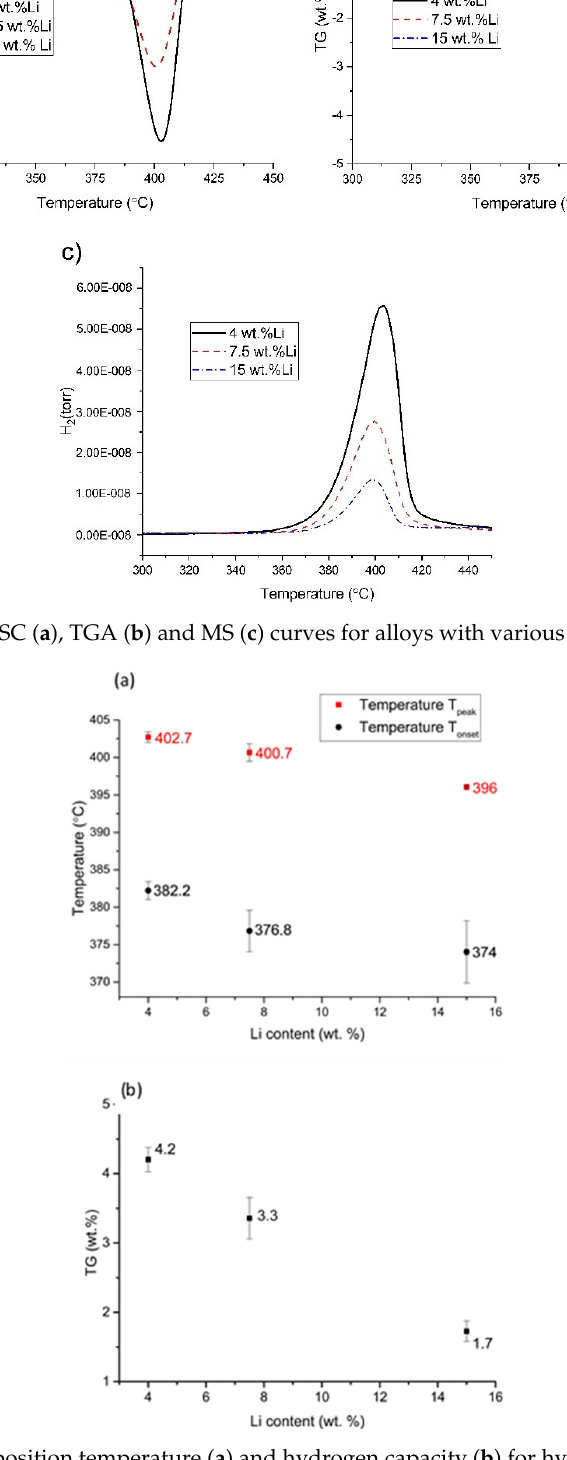
Figure 6. The decomposition temperature ( a ) and hydrogen capacity ( b ) for hydrides obtained using alloys with various lithium contents. Table 2. The hydrogenation properties of alloys with various lithium contents.